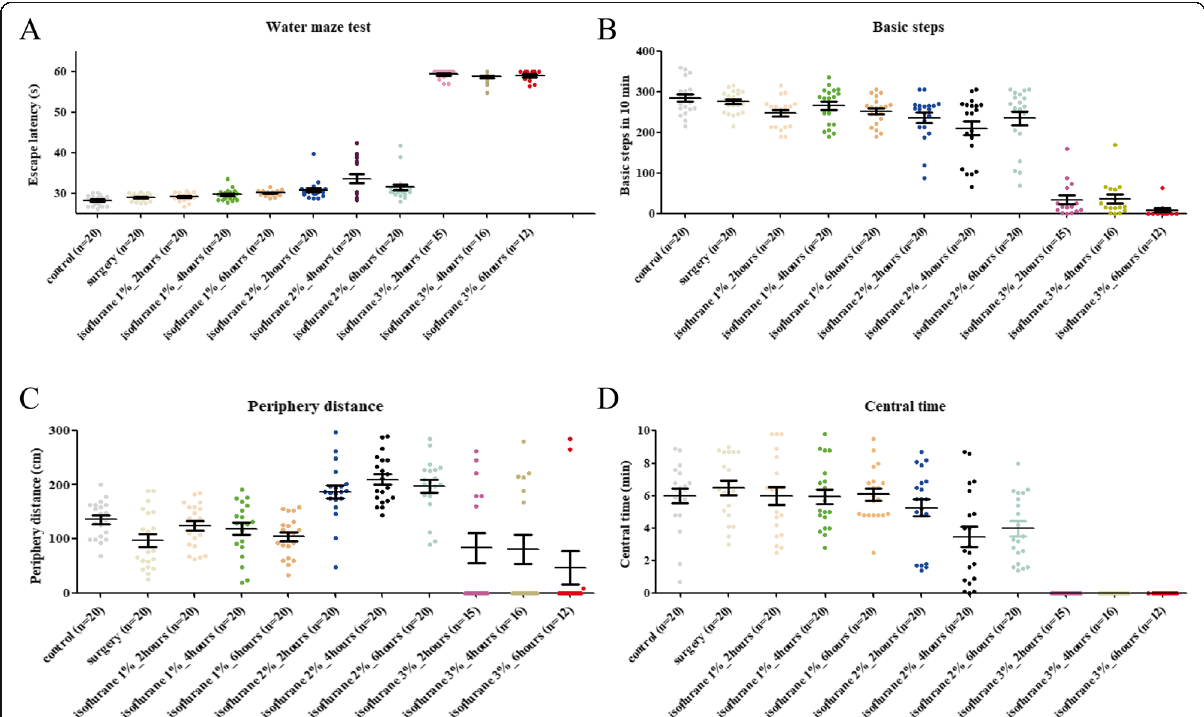
Fig. 1 POCD mice identified using water maze and open field test. The indexes of escape latency period ( a ) of water maze as well as basic steps ( b ), periphery distance ( c ) and central time ( d ) of open field test. “ * ” represents statistical